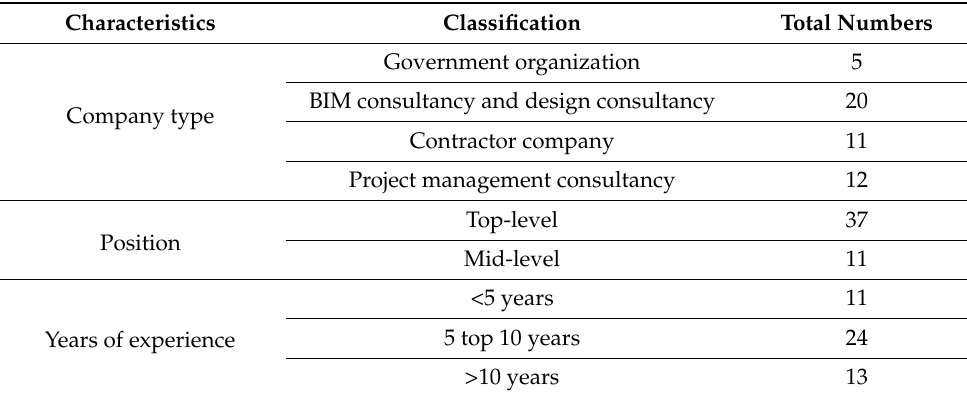
Table 3. Respondents’ details for Fuzzy DEMATEL